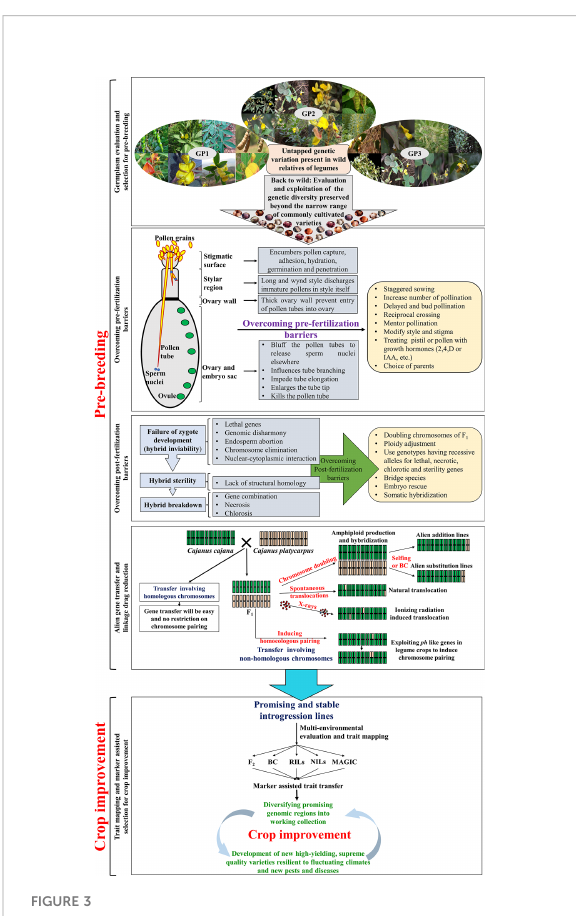
FIGURE 3 Strategies for pre-breeding and crop improvement in